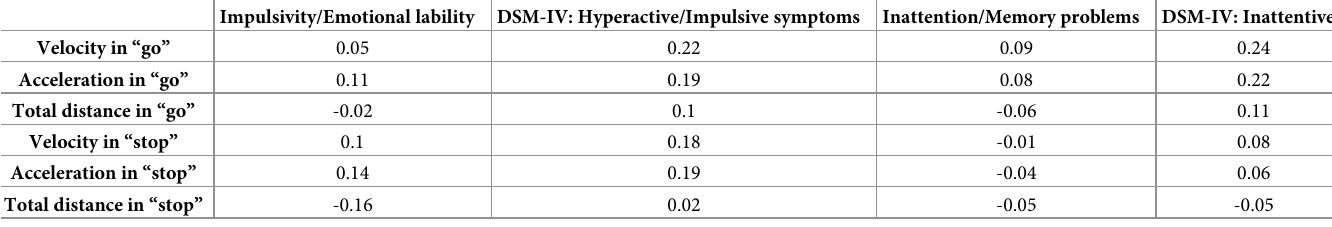
Table 18. Values of Spearman’s ρ for correlations between mouse measures and impulsivity/inattention measures at 80% coherency level.